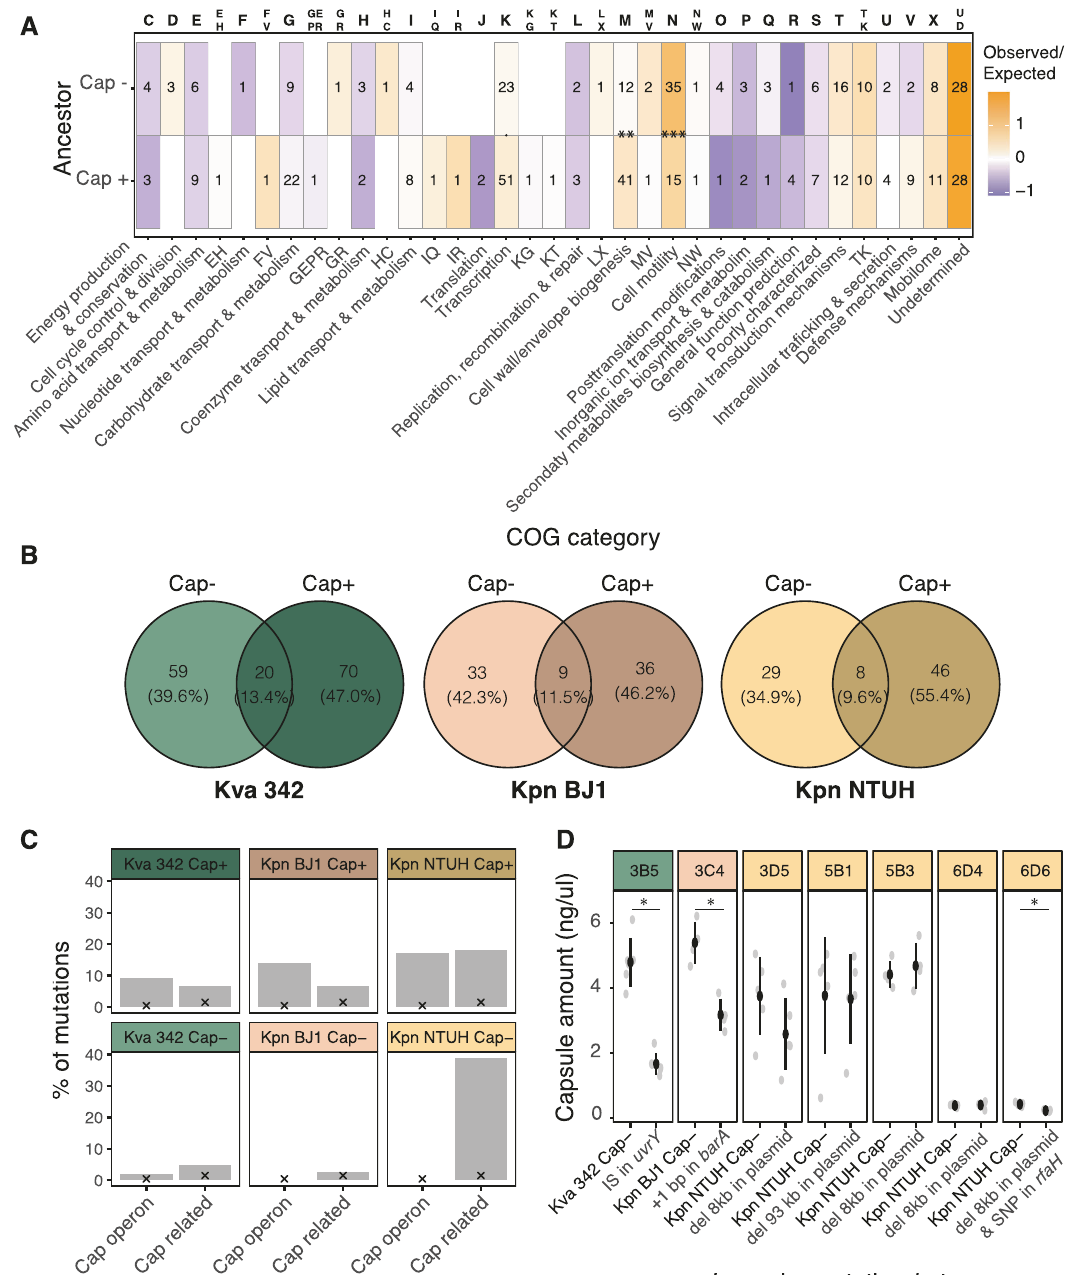
Fig. 2 | Comparison of mutations across ancestral genotypes. A Ratio of observed over expected number of mutations in genes annotated to each of the clusters of orthologous groups (COG category). Numbers represent absolute numberofmutations.Mutationsinintergenicregionsanddeletionsspanningmore thanone ORFwereeliminated from thisanalysis. Fisher ’ s test. * P =0.05,** P <0.01; *** P <0.001. B Venn diagram illustrating the number of genes mutated in clones from each ancestral genotypeand across strains. C Percentage of mutations found in the capsule operon or in capsule-related genes. ‘ X ’ indicates the percentage of